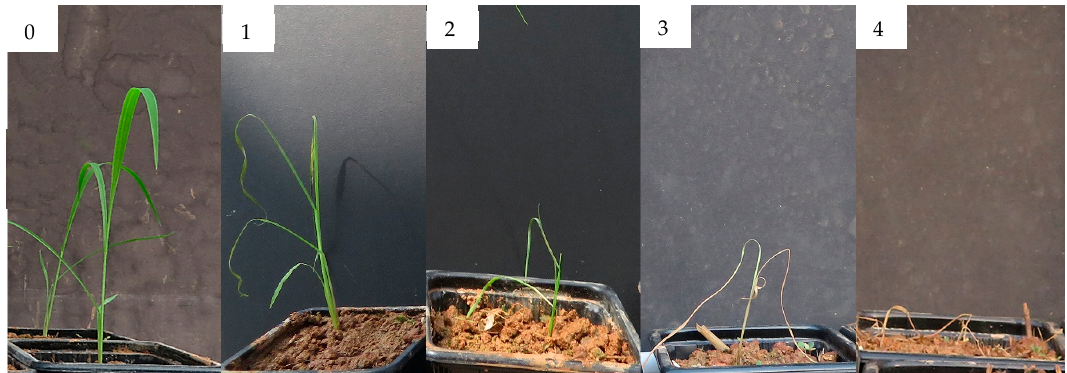
Figure 14. Damage level scale of Echinochloa crus-galli. 0 Undamaged plant, 1 Plant with slight damage, 2 Plant with severe damage, 3 Critically damaged plant, 4 Dead plant.